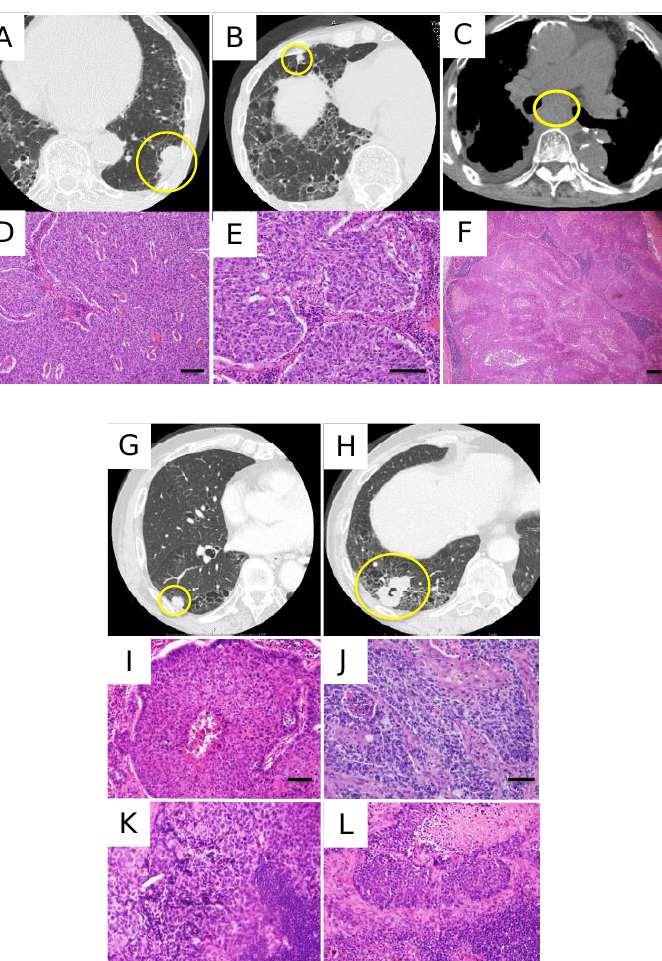
Figure 7. Radiological and histopathological findings in cases E and F. ( A – F ) Findings in case E. ( A ) Primary lesion in the left lower lobe. ( B ) Primary lesion in the middle lobe. ( C ) Subcarinal lymph node metastasis. ( D – F ) The three lesions displayed a similar histology of squamous cell carcinoma. ( G – L ) Findings in case F. ( G ) Primary lesion in right segment 6. ( H ) Primary lesion in right segment 9. ( I ) Histology of the primary lesion in segment 6. ( J ) Histology of the primary lesion in segment 9. ( K ) Histology of the subcarinal lymph node. ( L ) Histology of the interlobar lymph node. Histologically, the four lesions displayed a similar histology of squamous cell carcinoma. Each scale bar indicates 100 μm.